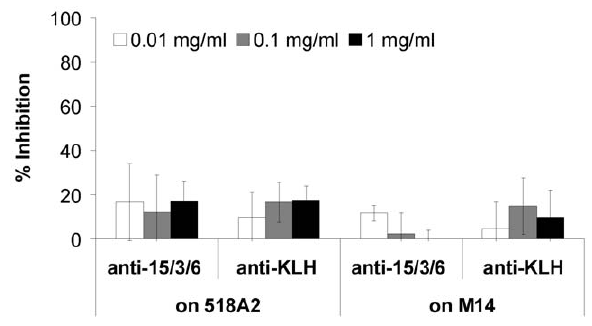
Figure 6. Inhibition of melanoma cell proliferation in vitro . [ 3 H]thymidine proliferation assay demonstrating effects of purified mouse IgG on HMW-MAA expressing melanoma cells. 518A2 or M14 cells were incubated with increasing concentrations of purified IgG from mice immunized with 15/3/6-KLH conjugate or KLH for 72 h and pulsed with [ 3 H]thymidine. Data are presented as percentage of inhibition of proliferation compared to untreated cells. Percentage of inhibition was calculated as follows: 100 2 (cpm (treated)/cpm (untreat- ed) 6 100). Values represent the mean of three independent experi-